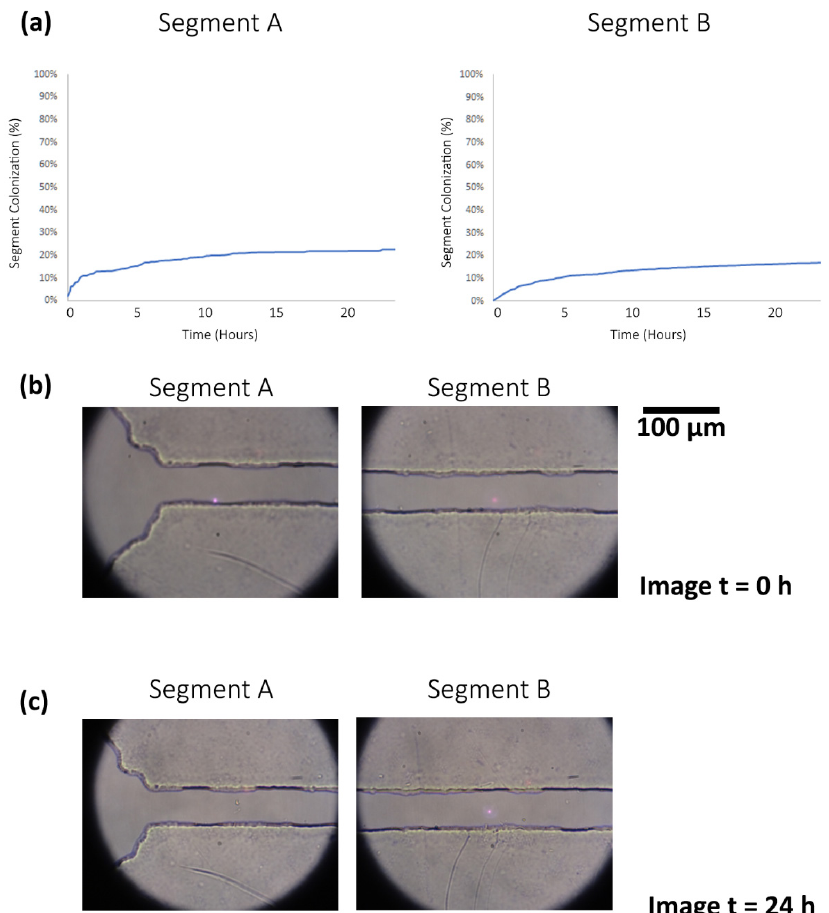
Figure A2. Control experiment. ( a ) Image analysis growth curve of control experiment at two di ff erent microsystem segments. RAW Images and binarized result at ( b ) t = 0 h and ( c ) t = 24 h.